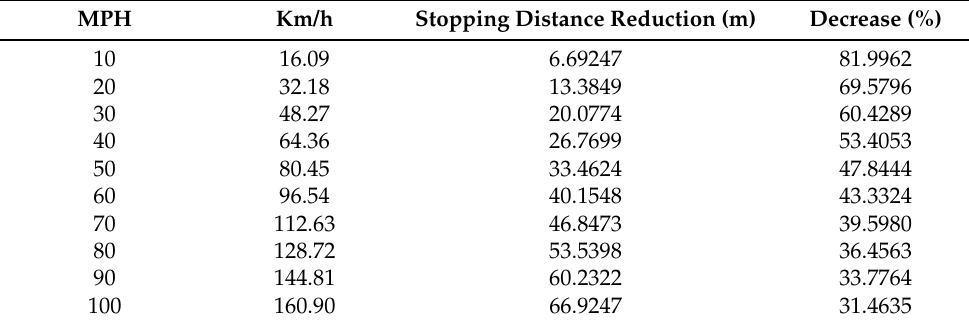
Table 3. Stopping distance reduction.